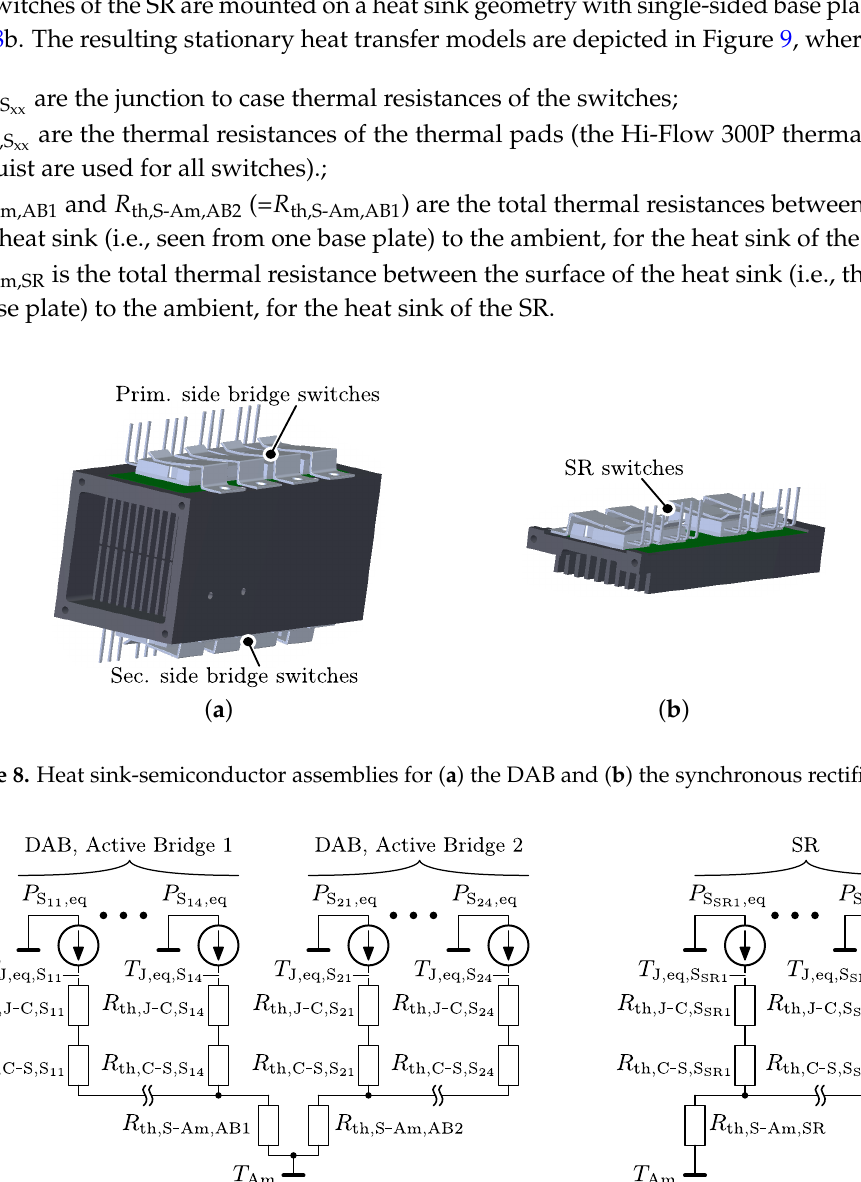
thermal pads ( A pad = 3.31 × 10 − 4 m 2 for the FCH76N60NF MOSFETs